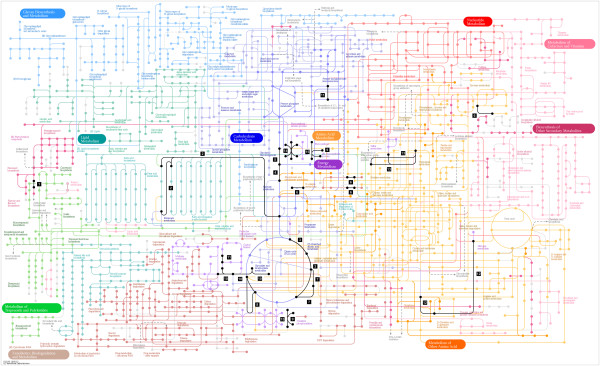
Mapping of the differentially regulated metabolic proteins during FDp infection according to KEGG “Metabolic pathways - Reference pathway (KO)”. The web-based server KAAS was used to display KEGG map assignments of the differentially regulated proteins. The “Metabolic pathways” map (in various colours) was the one that included the majority of the protein hits (1–15, in black). 1: anthocyanidine synthase; 2: acetyl-CoA acetyltransferase; 3: aconitate hydratase 2; 4: enolase; 5: 2,3-bisphosphoglycerate-independent phosphoglycerate mutase; 6: alcohol dehydrogenase 6; 7: isocitrate dehydrogenase; 8: succinate dehydrogenase; 9: ATP synthase CF1 alpha subunit; 10: ribulose-1,5-bisphosphate carboxylase/oxygenase large subunit; 11: ribose-5-phosphate isomerase; 12: glutamine synthetase; 13: cystathionine beta-synthase (CBS) and cysteine synthase-like protein; 14: oxygen-evolving enhancer protein 2 23-kDa polypeptide of photosystem II; 15: ATP synthase CF1 beta subunit.